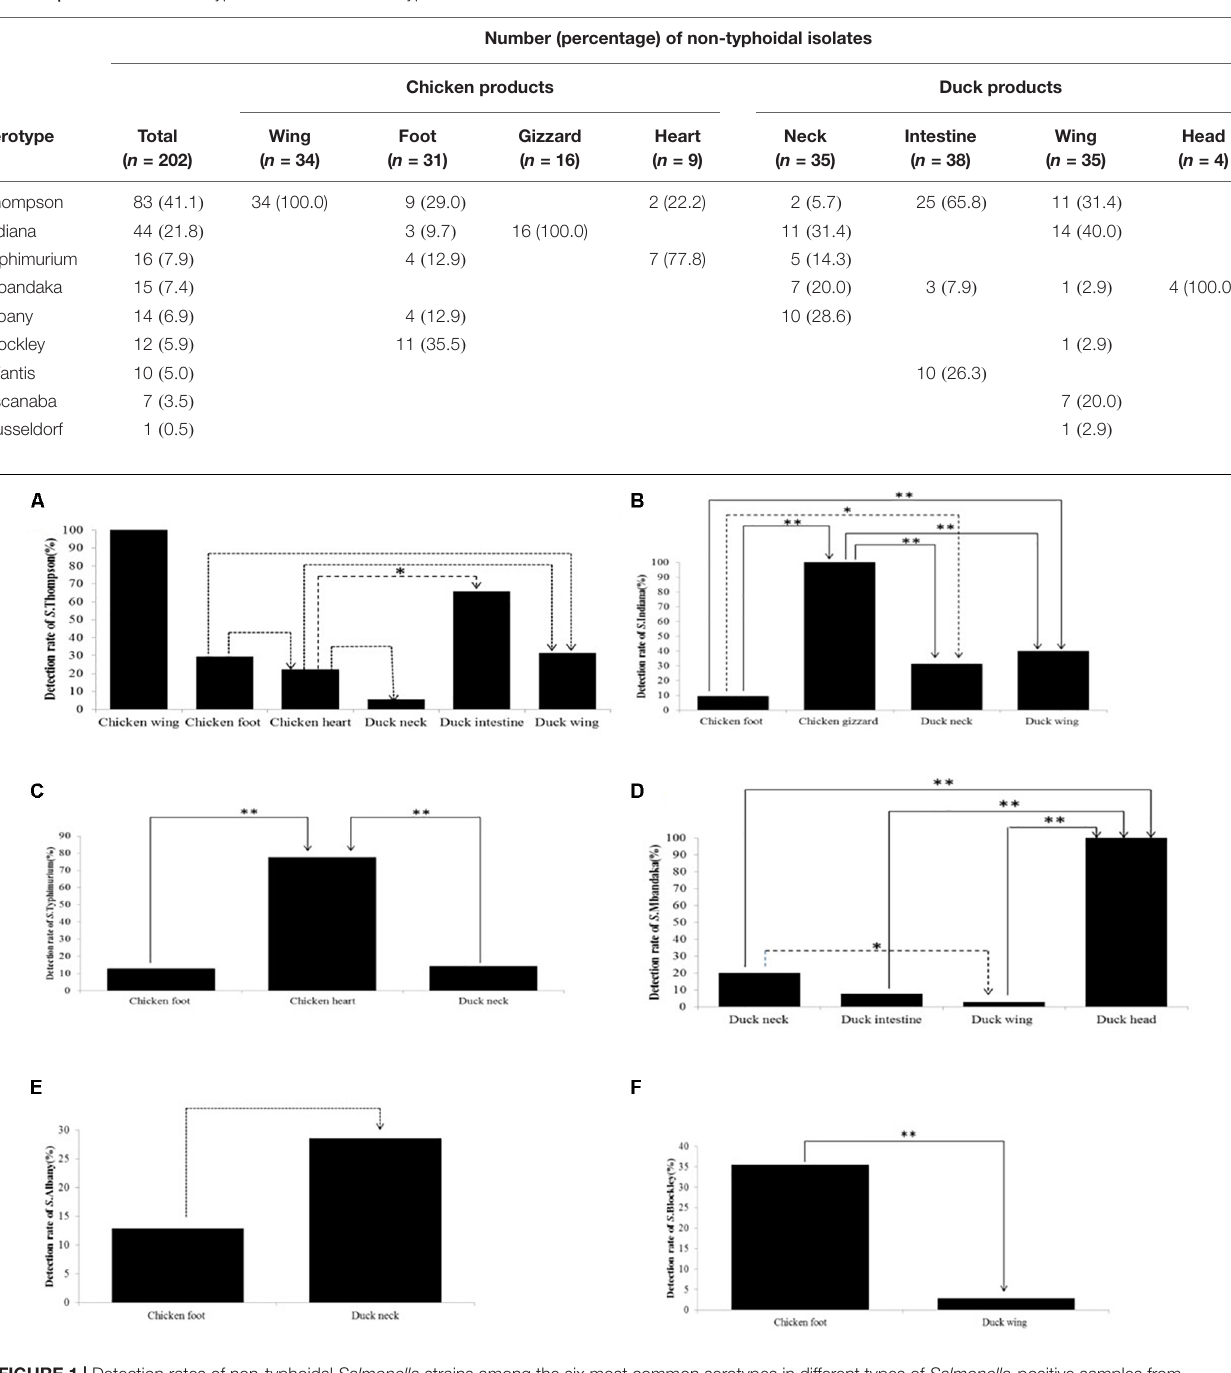
Almost all S. Thompson, S. Indiana, S.